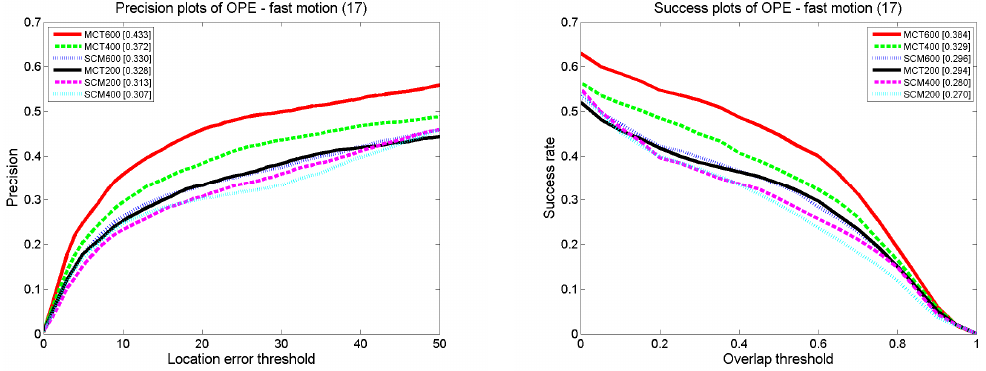
Figure 17. Comparison between MCT and MCT within different number of particles.